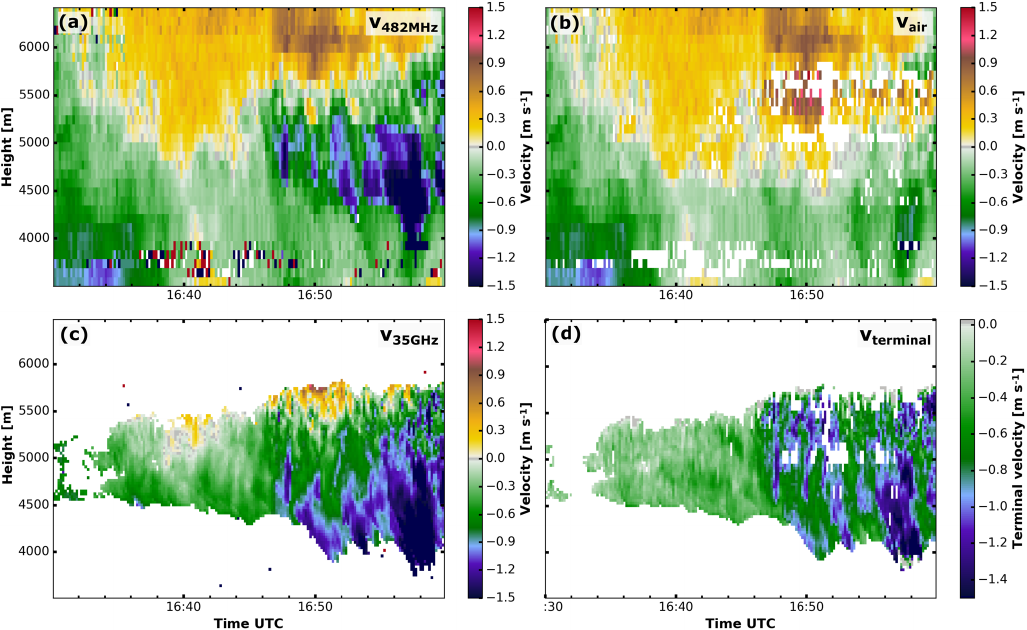
Figure 11. Close-up of the mixed-phase layered cloud between 16:30 and 17:00UTC. Vertical velocity retrieved with the standard RWP signal processing (a) , retrieved vertical air motion (b) , vertical velocity of the cloud radar (c) and the terminal velocity (d) . Values exceeding the velocity colour scale are shown in dark blue and